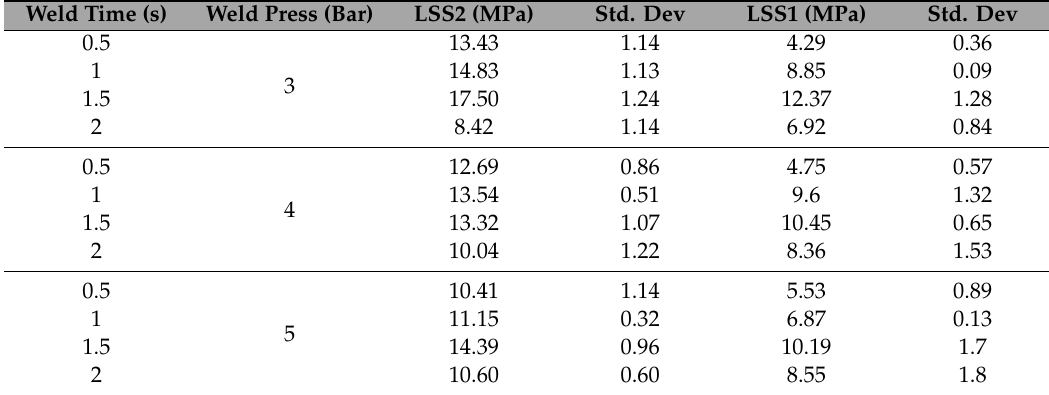
Table 4. LSS1 and LSS2 test results for the SC-ELC_FL-ELC configuration.